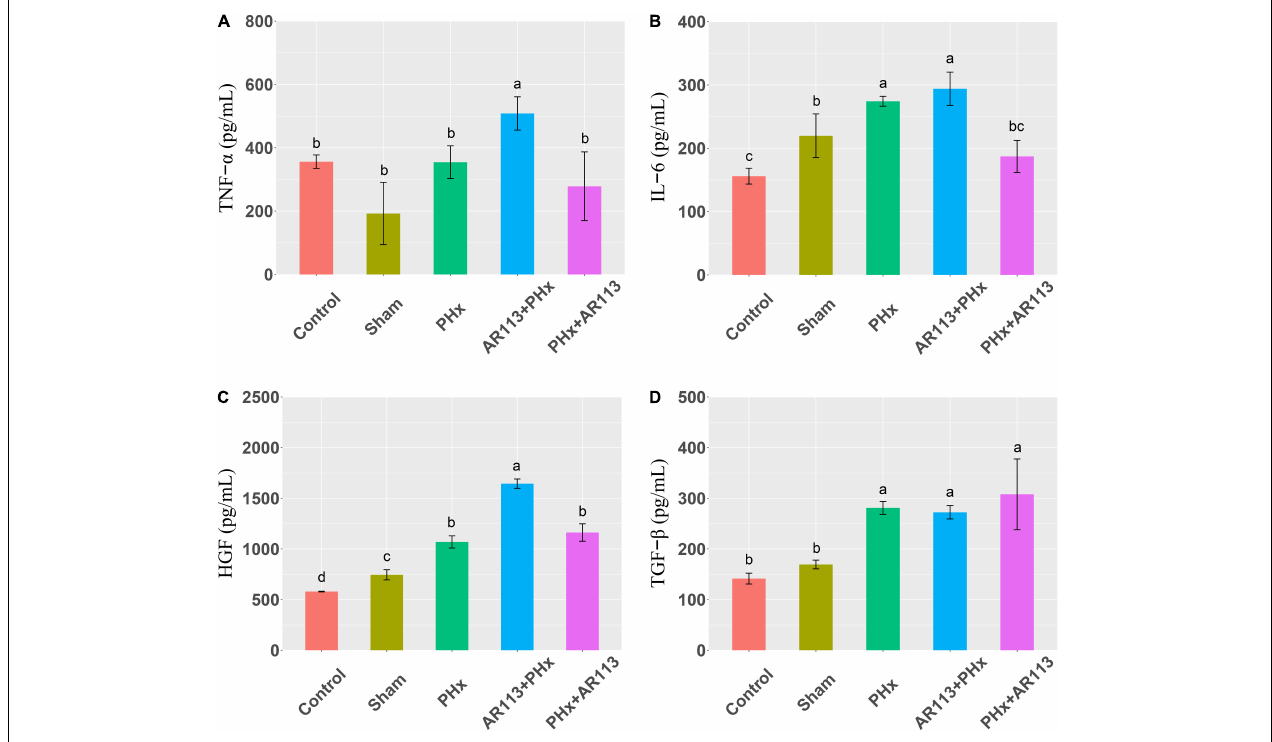
FIGURE 2 | Cytokines and growth factors at 3 days after PHx among the Control, Sham, PHx, AR113+PHx, and PHx+AR113 groups. (A) Changes in TNF- α levels; (B) Changes in IL-6 levels; (C) Changes in HGF levels; (D) Changes in HGF- β levels. Different letters indicate significant differences, P < 0.05 (ANOVA followed by Tukey’s HSD